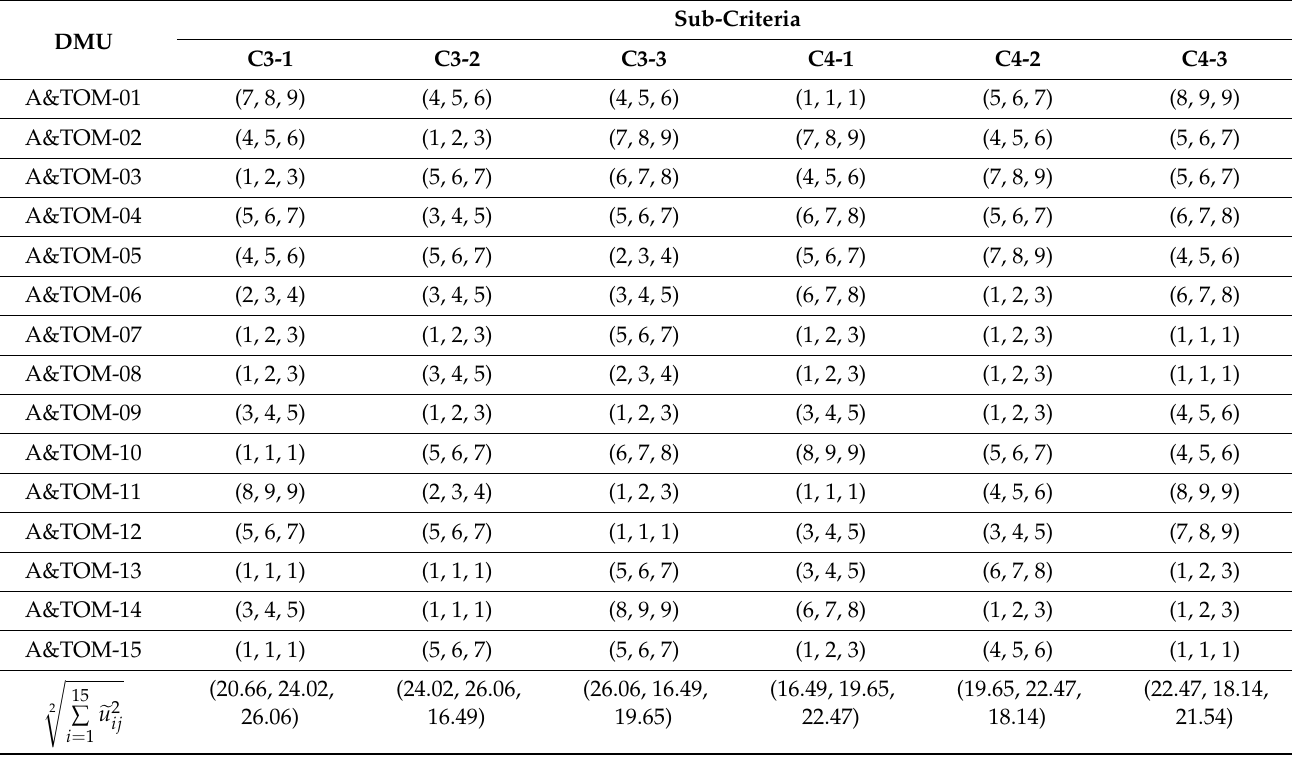
Table A2. Fuzzy decision matrix.